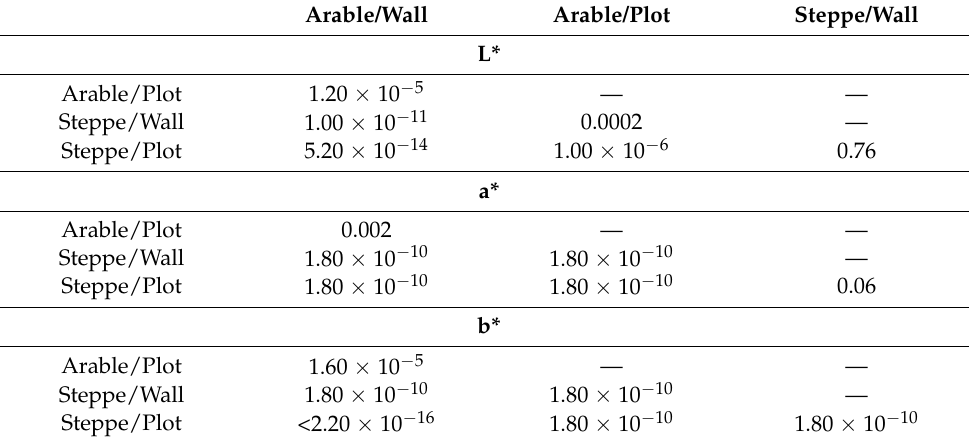
Table 5. Results of pairwise comparisons of mean values of color coordinates using the Mann– Whitney test ( p -values corrected by the Bonferroni